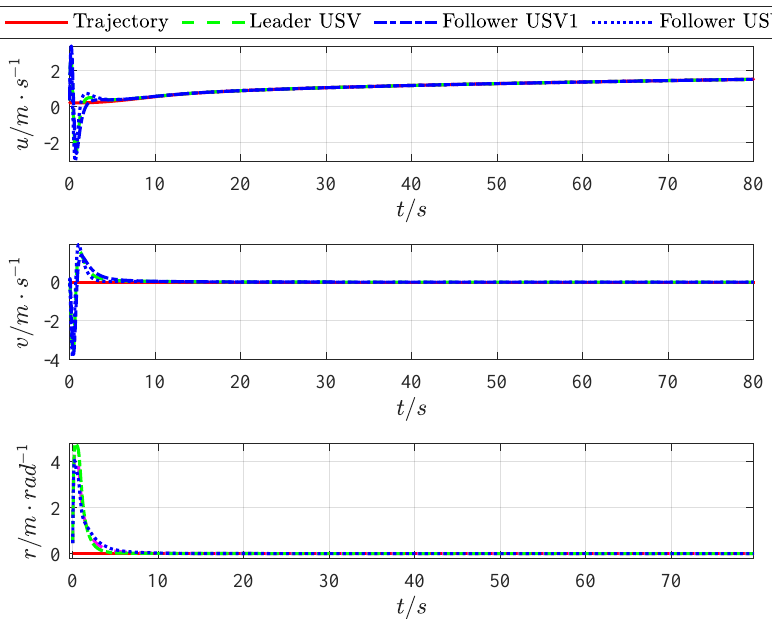
Figure 10. Velocity tracking of triangular formation of